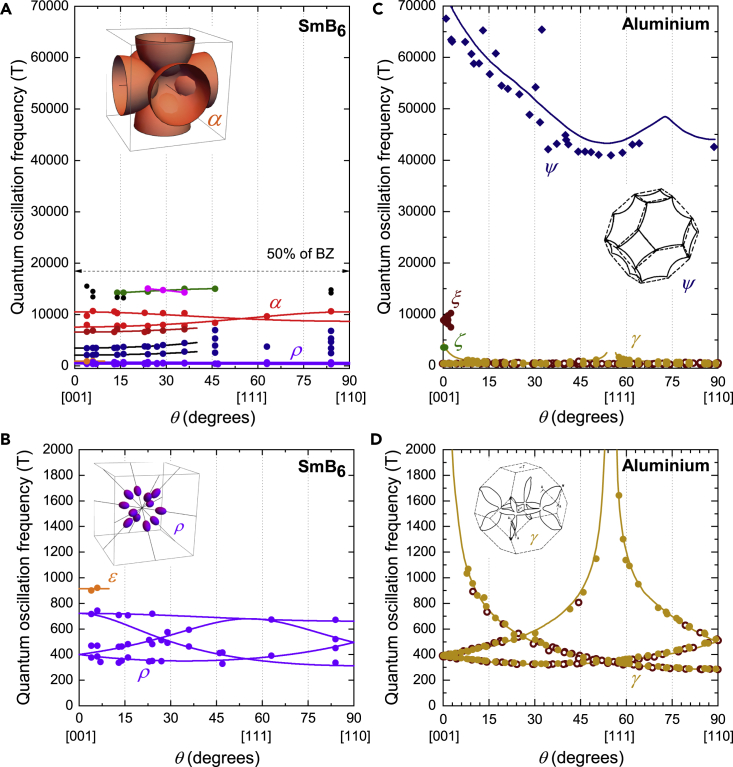
Comparison of Angular Dependence of Quantum Oscillation Frequencies in SmB6 and Elemental AluminumComparison on the same frequency scale of the measured angular dependence of quantum oscillation frequencies in the [001]-[111]-[110] rotation plane of floating zone-grown SmB6 (A and B) from Tan et al. (2015), with aluminum (C and D) from this study, Anderson and Lane (1970); Larson and Gordon (1967), and Boyne and Mackinnon (1978). The comparison of the high frequency branches in (A) and (C) shows a multitude of branches between 2 kT and 16 kT spanning the entire angular range for SmB6, but none for aluminum, which has a prominent high-frequency branch above 40 kT (circles are measured by this study, diamonds are from Anderson and Lane (1970), and squares are from Larson and Gordon (1967); Boyne and Mackinnon (1978)). The arrow denotes the maximum expected frequency for half-filling assuming a single spherical Fermi surface section, above which we would not expect to see frequencies for a metallic equivalent, similar to LaB6. (B) ρ branches found for SmB6 have a flat angular dependence corresponding to a Fermi surface of twelve ellipsoids along <110>, as shown in the illustration. (D) Frequencies for aluminum measured in this study show good overlap with previous measurements (brown circles (Larson and Gordon, 1967; Boyne and Mackinnon, 1978)), and trace the γ branches to much higher frequencies than previous measurements, with frequencies as high as 1600 T. A pronounced divergence of the measured frequencies is seen in the [110]-[001] rotation plane, corresponding to a necklace-like Fermi surface of elongated arms as shown in the illustration (taken from Harrison (1959)). Solid lines follow Ashcroft's model (Ashcroft, 1963) and are from Larson and Gordon (1967). Frequency points in Boyne and Mackinnon (1978) corresponding to harmonics are not shown. Illustrations of Fermi surface sections corresponding to the α and ρ sections in SmB6 are from Tan et al. (2015), while those corresponding to the ψ and γ sections in aluminum are from Harrison (1959).